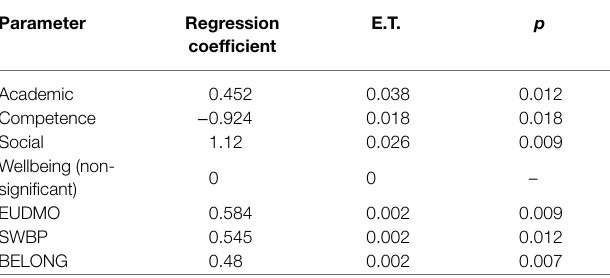
TABLE 9 | Results (regression coefficients and significant effects) for emotional factor. Parameter Regression